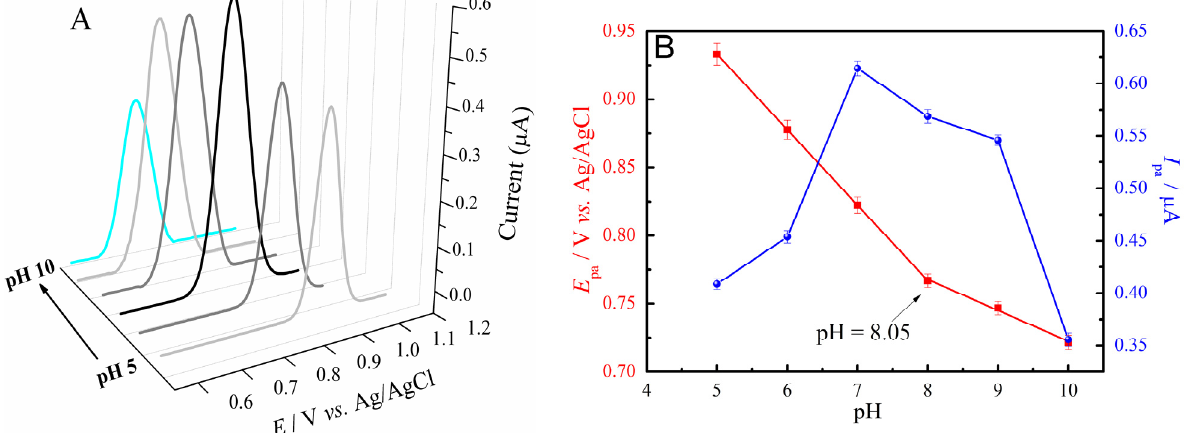
Figure 3. ( A ) DPV voltammograms using the GC/RC-SbNP electrode in the presence of 10.0 µmol L − 1 in a 0.1 mol L − 1 PBS solution at different pH, from 5.0 to 10. ( B ) Effect in I pa ( ◼ ) and E pa ( ● ) as